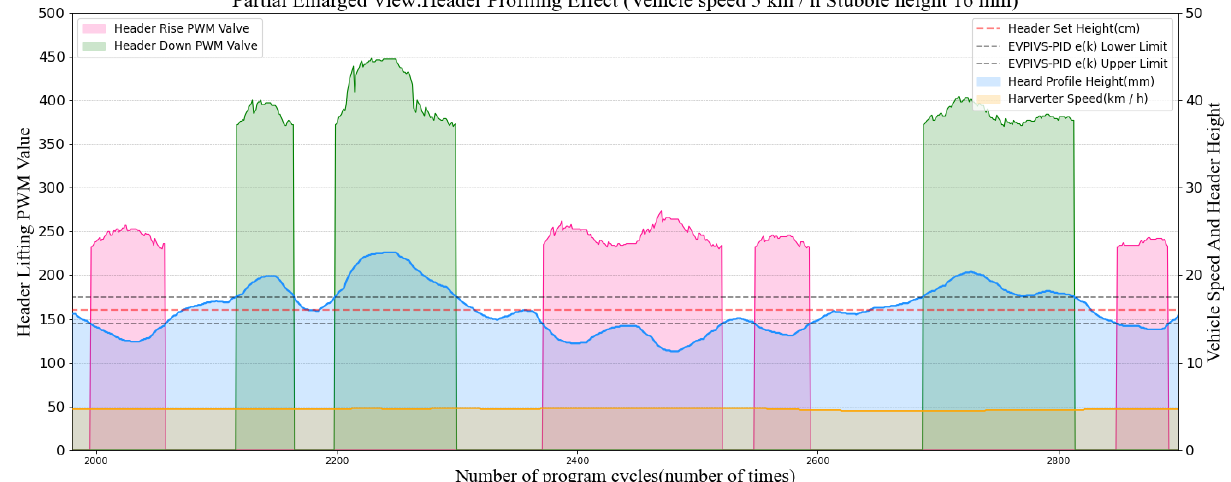
Figure 22. Partial enlarged view.